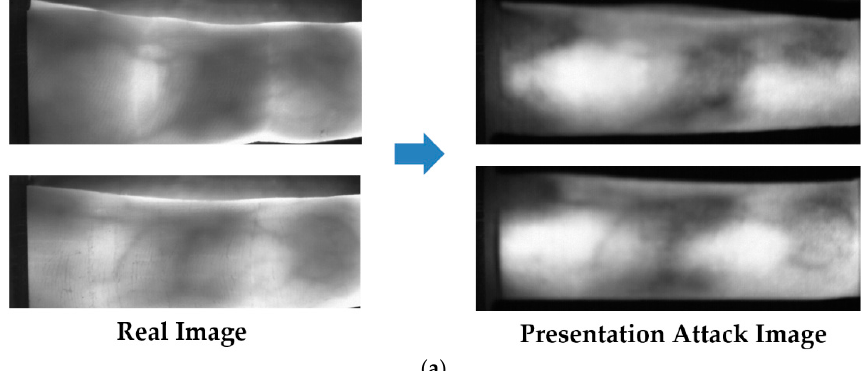
Figure 5. Example of real and presentation attack finger-vein images in Idiap database: ( a ) real and presentation attack finger-vein images from full image database (Idiap Full-DB); and ( b ) real and presentation attack finger-vein images from cropped image database (Idiap